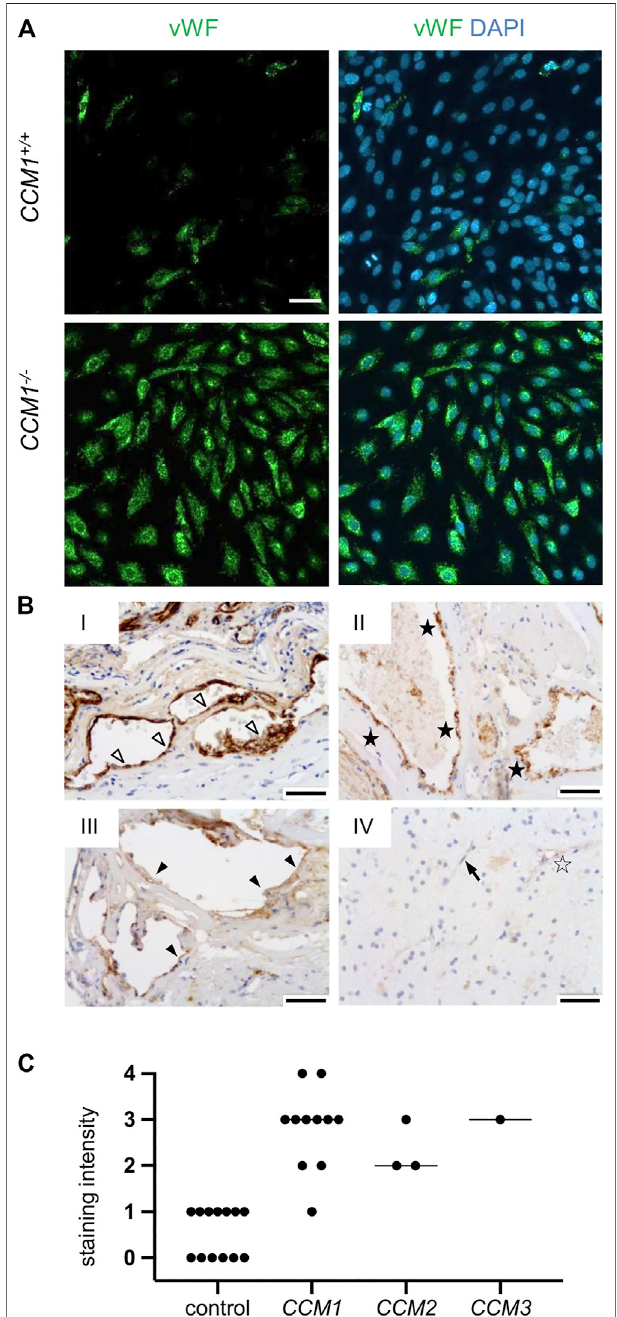
FIGURE4| High-levelVWFexpressionisacommonfeatureofCCMdisease. (A) Strong immunopositivity for VWF (shown in green) was also found in clonally expanded CCM1 − / − CI-huVECs. DAPI (blue) was used as nuclear counterstain. Confocal images were acquired using a 10x (NA 0.45) objective. Scale bar indicates 50 µm. (B) Immunohistochemistry demonstrated medium to strong VWF staining intensities (SI) in CCM tissue samples of hereditary cases (I-III). IV (cid:2) normal brain. Representative images are shown. Open arrowhead (cid:2) [SI] 4, black asterisk (cid:2) [SI] 3, fi lled arrowhead (cid:2) [SI] 2, open asterisk (cid:2) [SI] 1, arrow (cid:2) [SI] 0. Scale bars indicate50 µm.Thegraphdisplaysthestainingintensityofnormalbrainvesselsinthe vicinity of CCMs ( n (cid:2) 13) and of cavernous vessel endothelia in CCM1 ( n (cid:2) 11), CCM2 ( n (cid:2) 3), and CCM3 ( n (cid:2) 1) probands. Bars indicate the median.